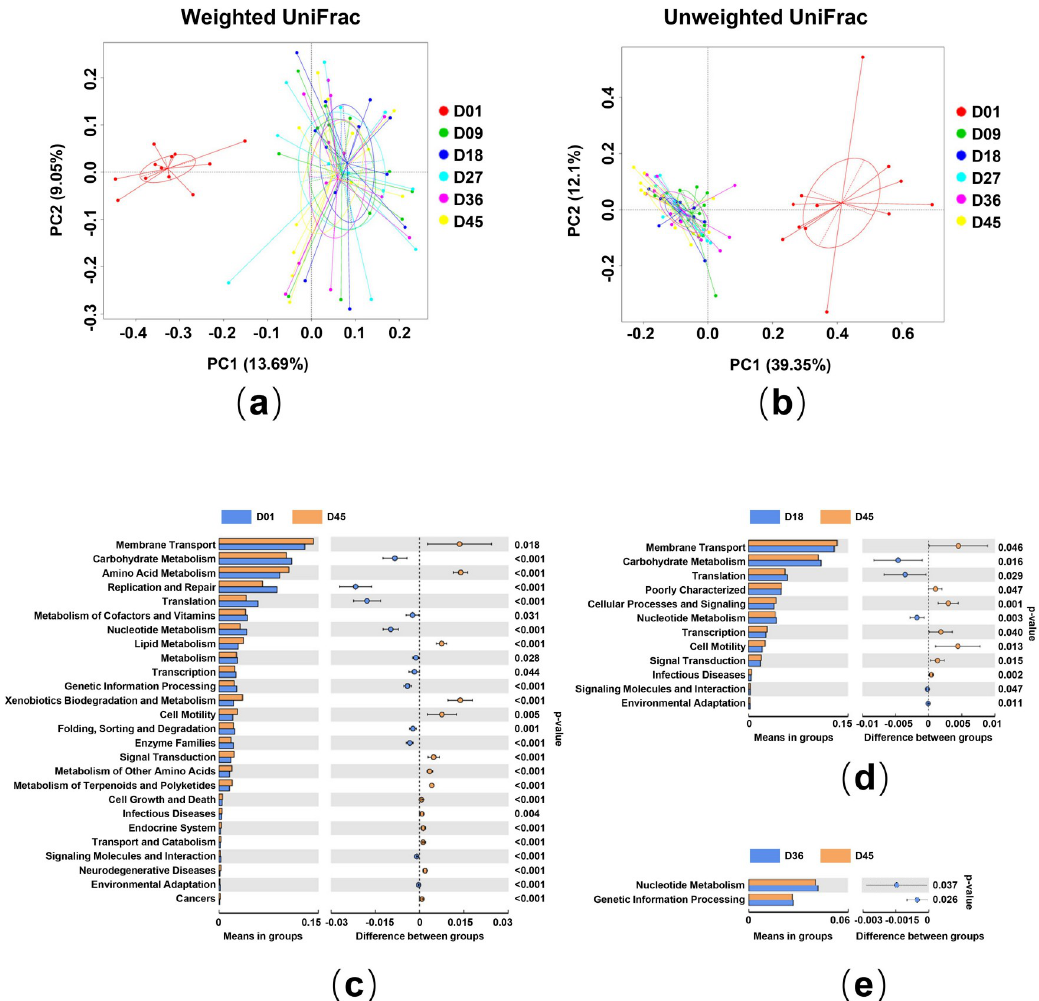
Fig 2. Exposition of bacterial beta diversity and microbial metabolic pathways at different ages of crested ibis nestlings. (a, b) Microbiota separation based on principal coordinates analysis (PCoA) from (a) unweighted UniFrac distances and (b) weighted UniFrac distances. The default ellipse was the standard deviation of the group medians. (c-e) Differences in microbial functions between different ages based on KEGG functional categories predicted by PICRUSt. (c) D01 vs. D45; (d) D18 vs. D45; (e) D36 vs. D45. The extended error bar plot denotes the difference in the mean proportion of microbial metabolic pathways between the groups along with the associated confidence interval of the effect size and the p-value of Welch’s t-test (P < 0.05).